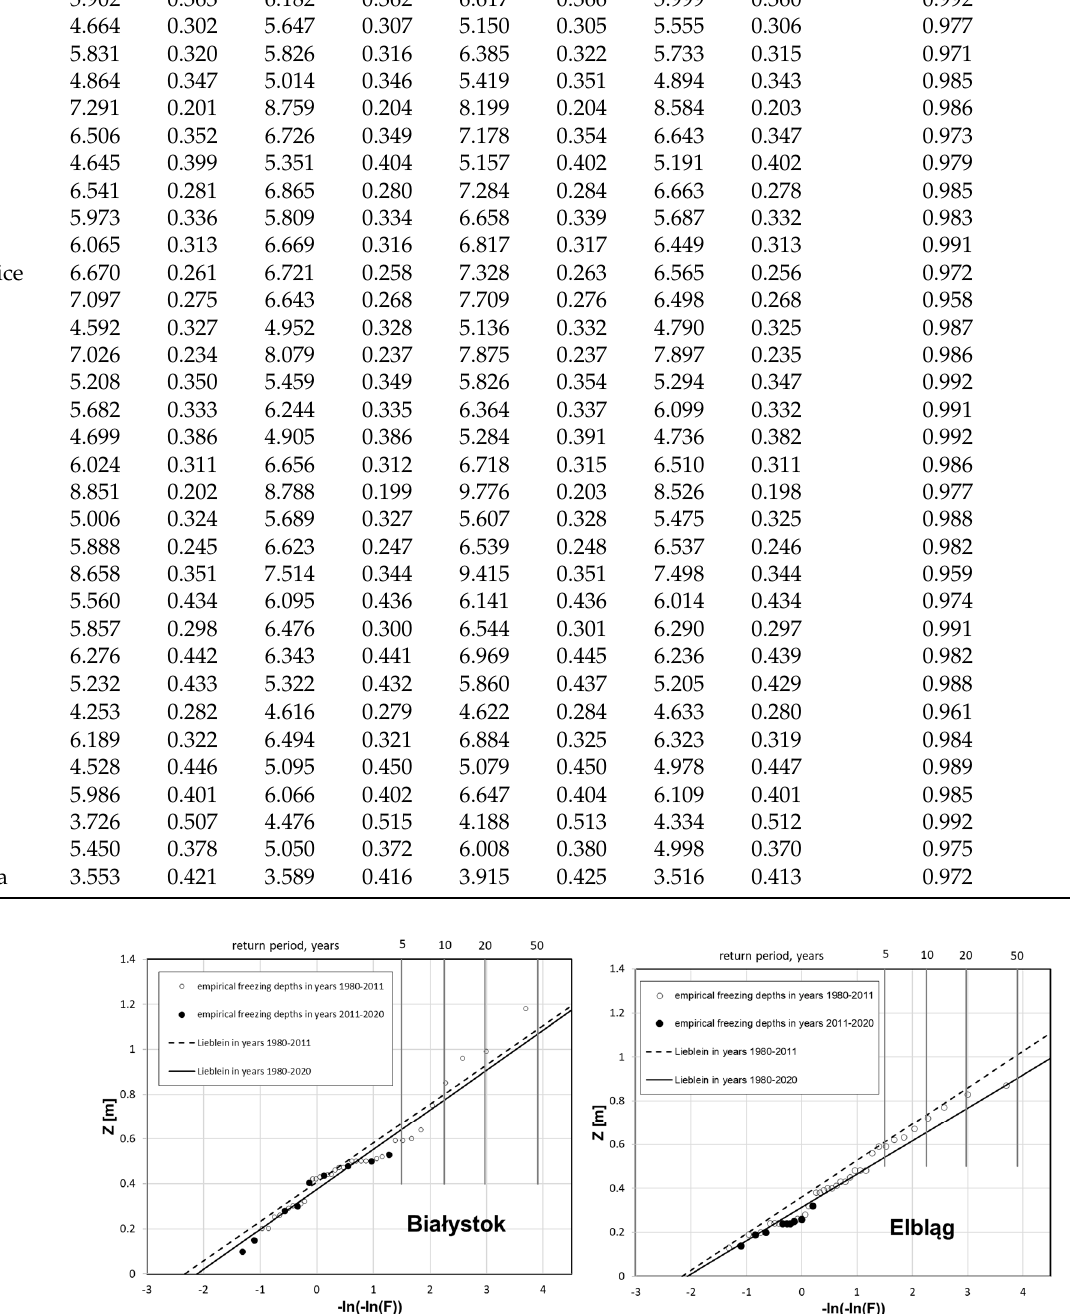
Figure 8. Comparison of predicted and measurement value for chosen location: Jelenia Góra ( left ) and Kalisz ( right ) station .